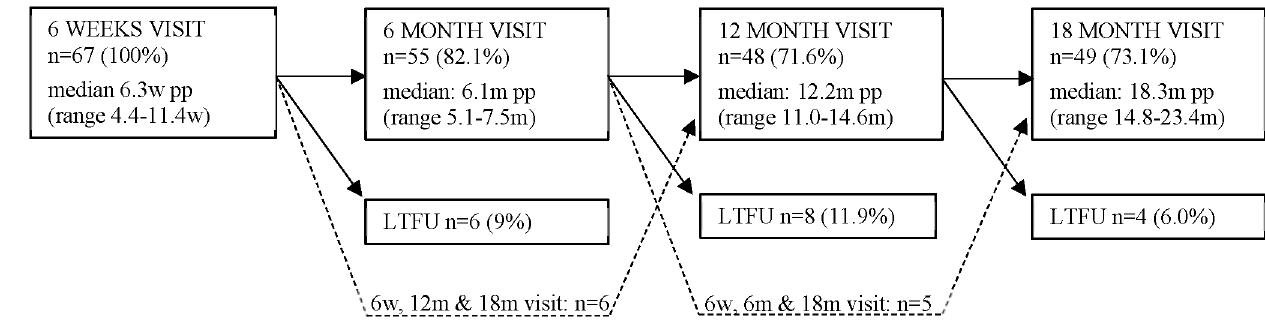
Fig 1. Option B+ enrolled women attending postpartum study